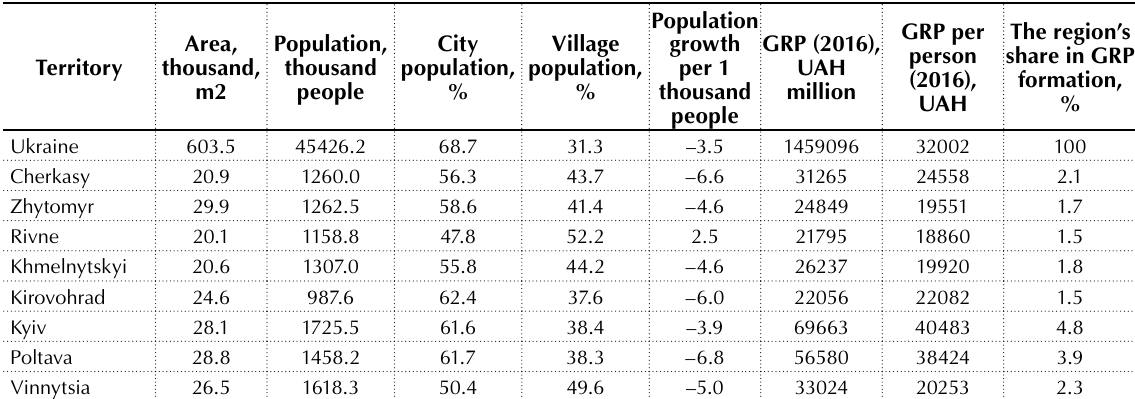
Table 3. Comparative characteristic of Cherkasy region by main indicators of the economic development as of January 1,